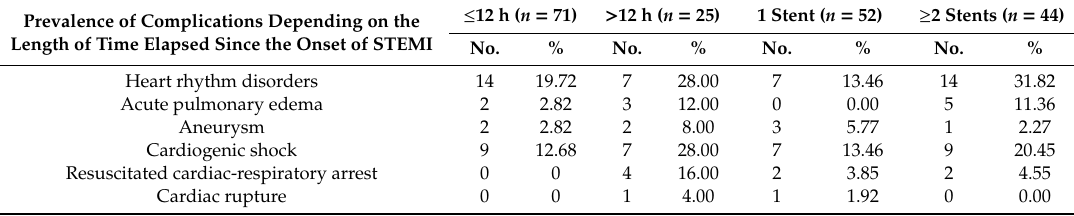
Table 3. Prevalence of complications depending on the time elapsed since the onset of STEMI and the number of implanted stents in NRP+ group.